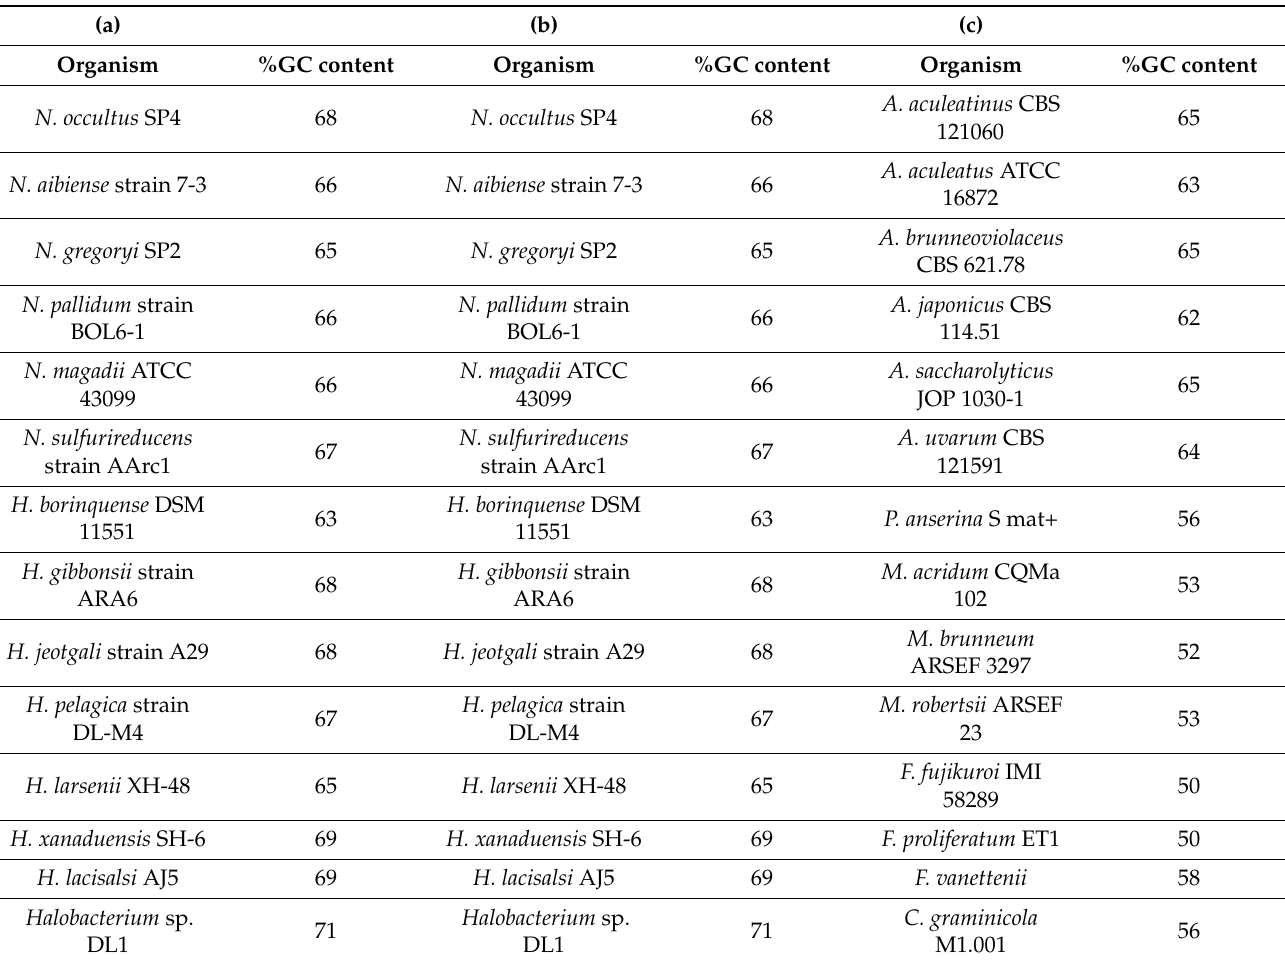
Table 3. The %GC content comparison of ( a ) Aeropyrum pernix K1 and archaeal cluster, ( b ) Salinibacter ruber and archaeal cluster, ( c ) Sadriomycetes and Euratiomycetes cluster, ( d ) Sadriomycetes and Blastocystis.sp branch, ( e ) Fusobacterium sp. branch and Entamoeba histolytica HM-1 and ( f ) Bacteroides.sp branch and Trichomonas vaginalis